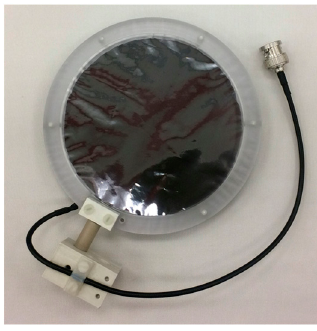
Figure 8. Picture of the SEM detector developed for the ELIMAIA beamline.